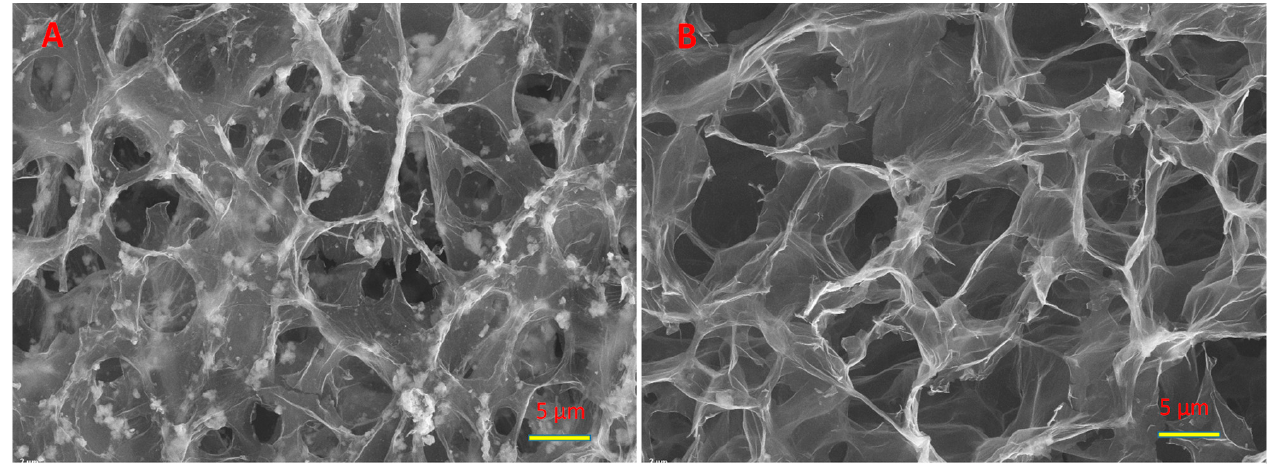
Figure 4. SEM micrographs of composite ( A ) and pure ( B ) aerogels.